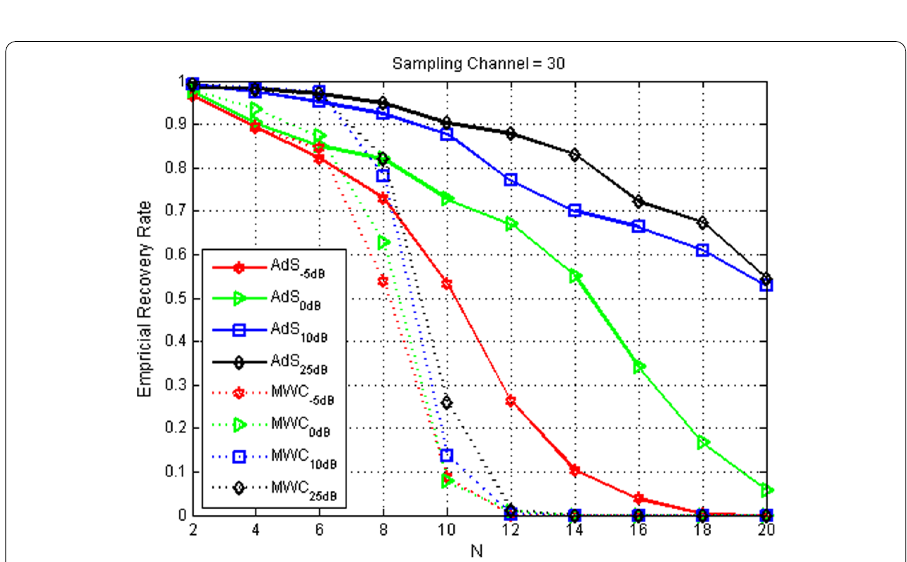
Fig. 11 Percentage of correct support recovery, when SNR